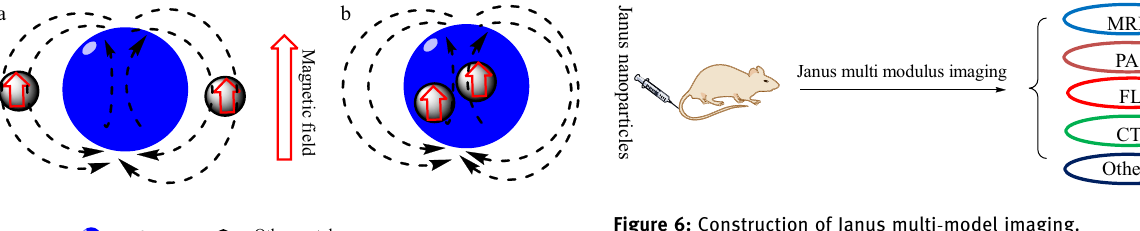
Figure 6: Construction of Janus multi - model